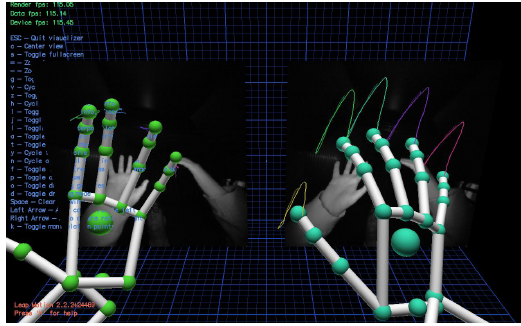
Figure 7. Snapshot of the creation of base gestures - Creation of Complex gesture (fig. 8): by merging multiple "gesture bases" we created interactions in the environment, such as touch and rotation of objects, scroll and analysis between different archaeological data, etc.